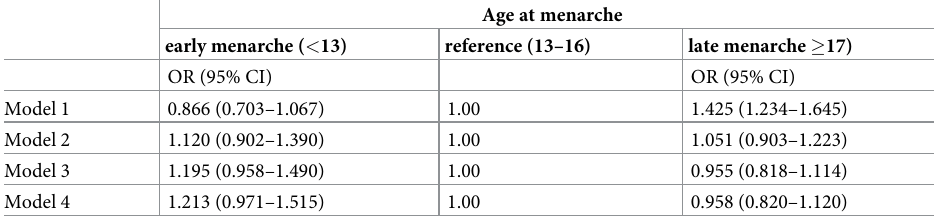
Table 4. Age at menarche and risk of metabolic syndrome.